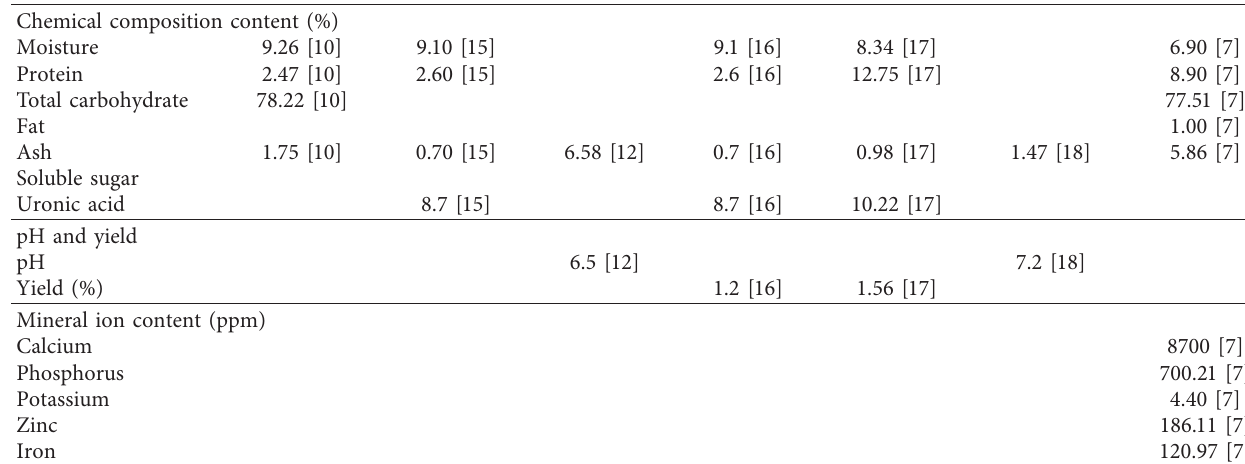
Table 1: Constitution contents and pH amounts related to gum Cordia